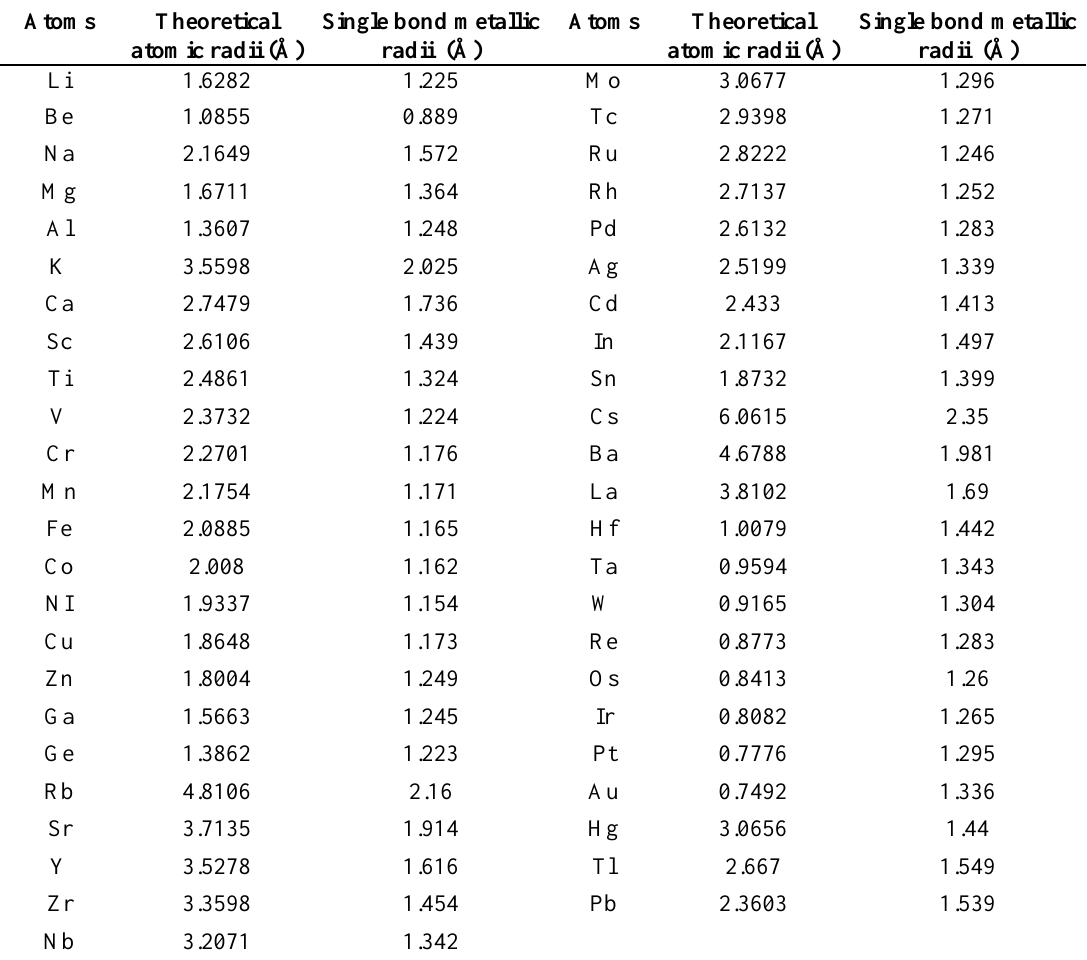
Table 4. Comparative study of theoretical radii and Pauling’s experimental metallic radii of atoms. Atoms